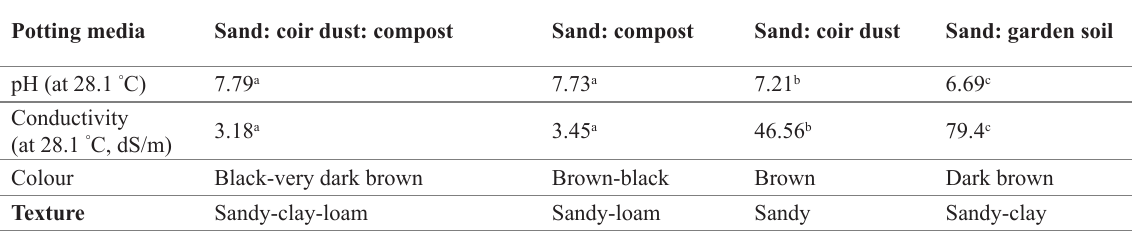
Table 2: Characteristic features (pH, salinity and colour) of the potting media (ratio either 1:1:1 or 1:1) used during the experiments Potting media Sand: coir dust: compost Sand: compost Sand: coir dust Sand: garden soil